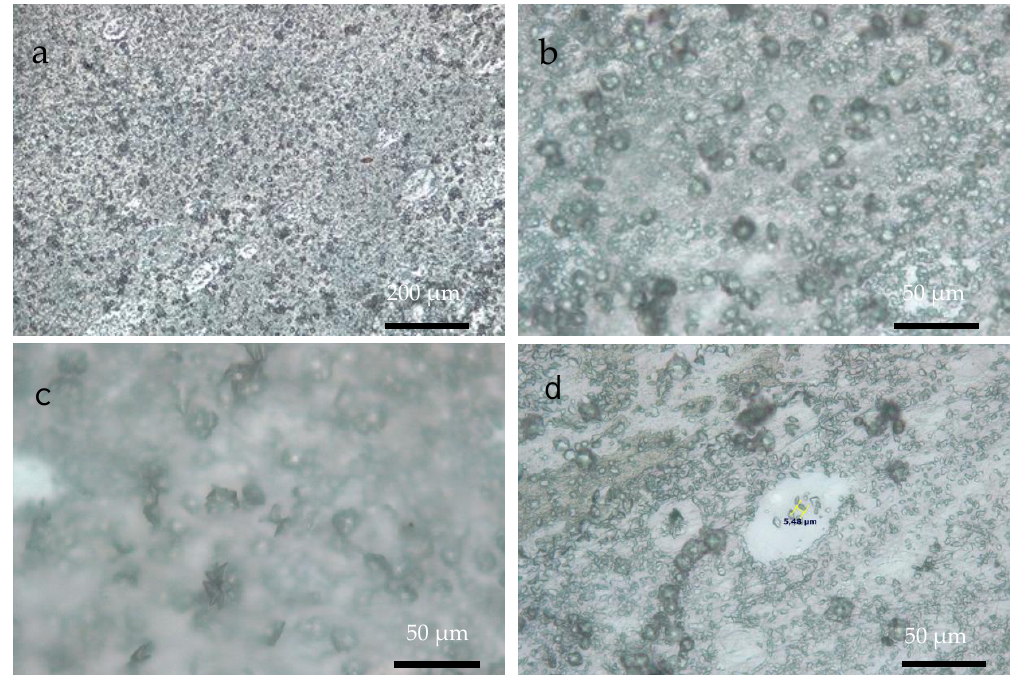
Figure 8. OM images of CaOx crystals obtained on ITO substrate modified with A-chitosan fibers ( a ) 10× and ( b – d ) 40× magnifications.